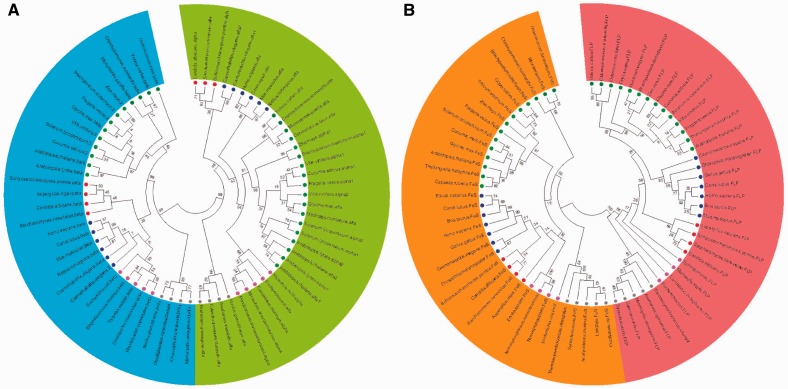
The phylogenetic tree of (A) succinl-CoA ligase and (B) SDH. Trees were built using putative amino acids sequences from (A) succinyl-CoA ligase highlighting the two subunits: Alpha (green background) and beta (blue background); and (B) SDH highlighting two subunits: Flavoprotein (red background) and iron-sulfur (orange background). Sequences of putative proteins from plants are highlighted by green circle, yeast by red circle, animals by blue circle, algae by dark green circle, bacteria by pink circle, and cyanobacteria by gray circle.